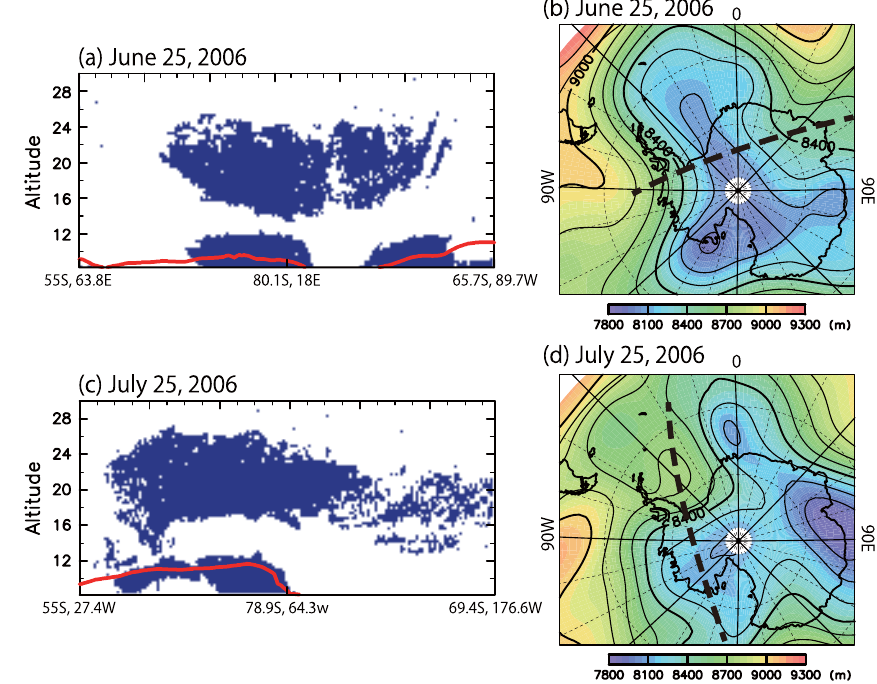
Fig. 12. (a) The distribution of PSC/UC flags (blue color) in the horizontal and height sections along the CALIPSO on 25 June 2006. A red curve indicates the blended tropopause height. (b) A polar stereo projection plot of geopotential heights (in color; unit is m) at 300hPa. The broken thick curve indicates the satellite track in (a) . (c) and (d) the same as (a) and (b) , respectively, but for 25 July